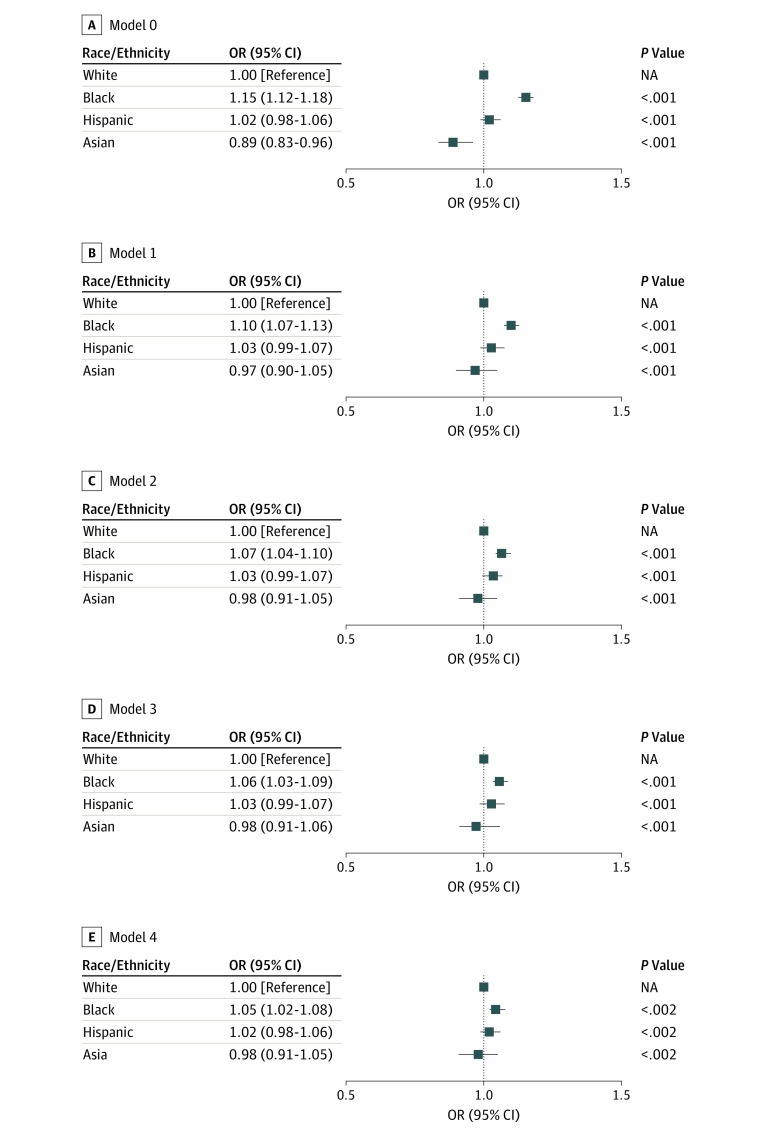
Relative Contributions of the 5 Risk Factor Categories on Observed Disparities in Readmission RiskA, Adjusted for demographic characteristics (age and sex). B, Adjusted for demographic characteristics and clinical factors (ie, individual comorbidities, complications associated with diabetes, and insulin use). C, Adjusted for demographic characteristics, clinical factors, and index hospitalization factors (ie, length of stay, discharge year, and prior hospitalization). D, Adjusted for demographic characteristics, clinical factors, index hospitalization factors, and economic factors (ie, annual household income). E, Adjusted for demographic characteristics, clinical factors, index hospitalization factors, economic factors, and hospital factors (ie, hospital ownership status, teaching status, urban status, sole community hospital status, and bed number). NA indicates not applicable; OR, odds ratio.